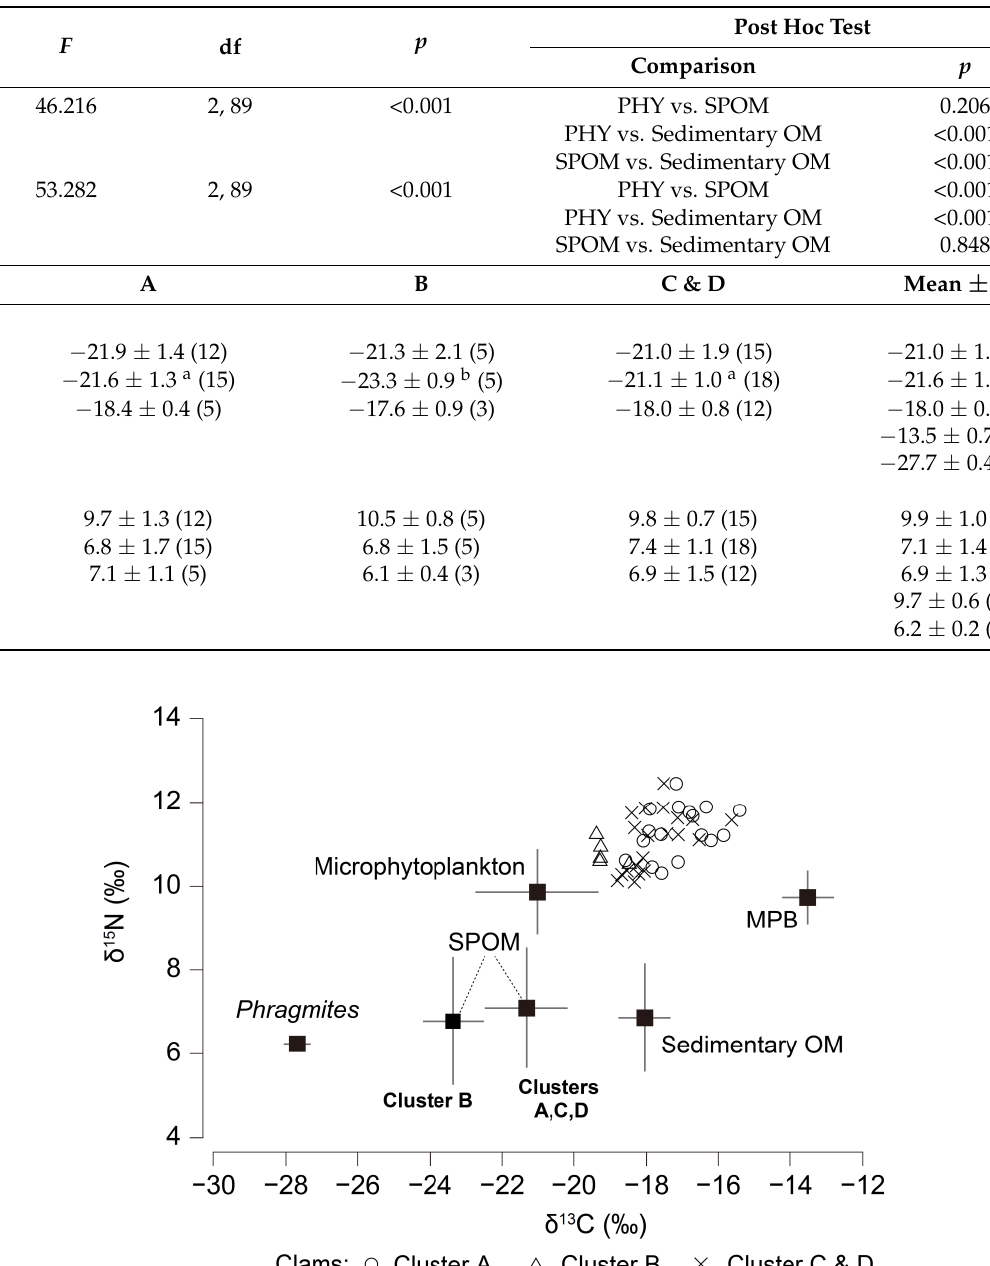
Table 3. δ 13 C and δ 15 N values (‰) of primary organic matter sources. The significance of differences in δ 13 C and δ 15 N values among potential food sources and SOM clusters was tested using a one-way analysis of variance (ANOVA) followed by the Tukey post hoc test. Data are the mean ± 1SD and the number of samples ( N ) is in parentheses. PHY, microphytoplankton; SPOM, suspended particulate organic matter; Sedimentary OM, sedimentary organic matter; MPB, microphytobenthos. The same superscript marked with mean ± 1SD values indicates no significant differences in mean values ( p > 0.05). * Isotope data for MPB and Phragmites (unpublished, C. Kim).